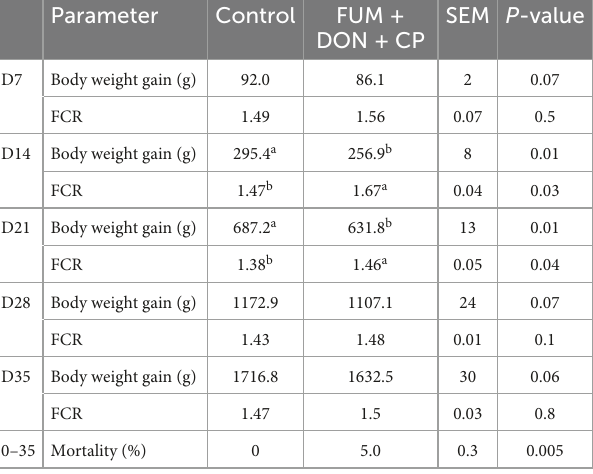
TABLE 1 Effect of subclinical fumonisins (FUM) and deoxynivalenol (DON) contamination on production parameters.